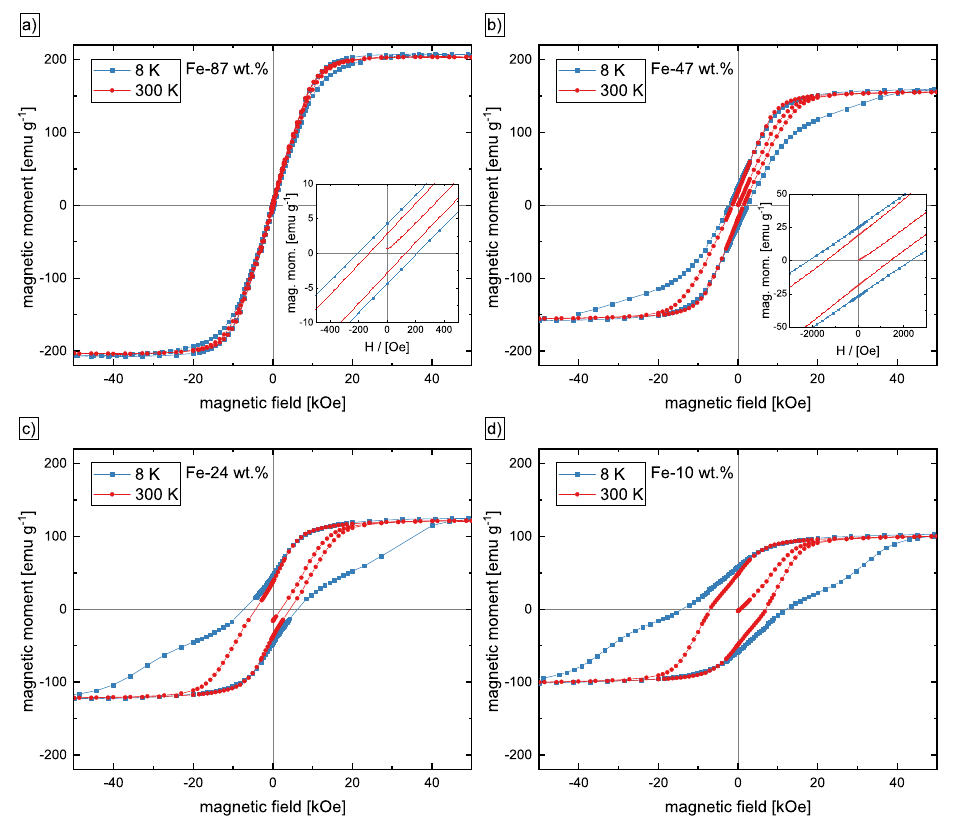
Figure 6. Hysteresis loops of HPT processed Fe-SmCo samples measured at 300 K (red, dots) and 8 K (blue, cubes) consisting of ( a ) 87, ( b ) 47, ( c ) 24 and ( d ) 10 wt.% Fe. All diagrams are identically scaled, therefore insets in ( a , b ) help to directly compare the coercivities at different